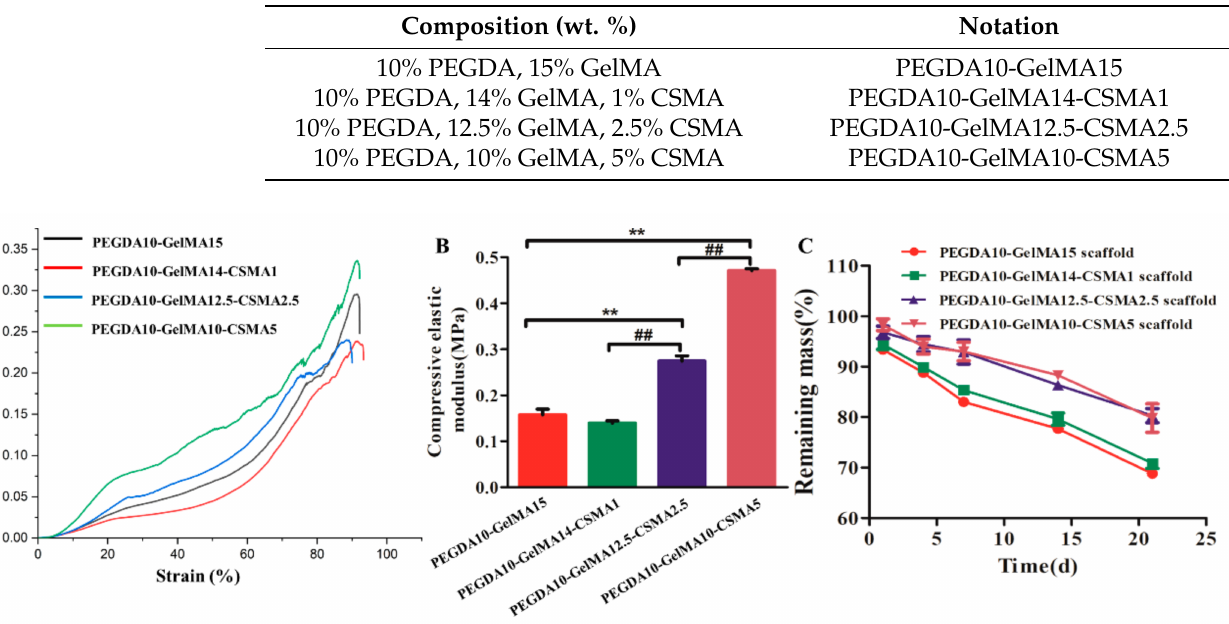
Table 2. Composition and notation of 3D scaffolds tested in this study.